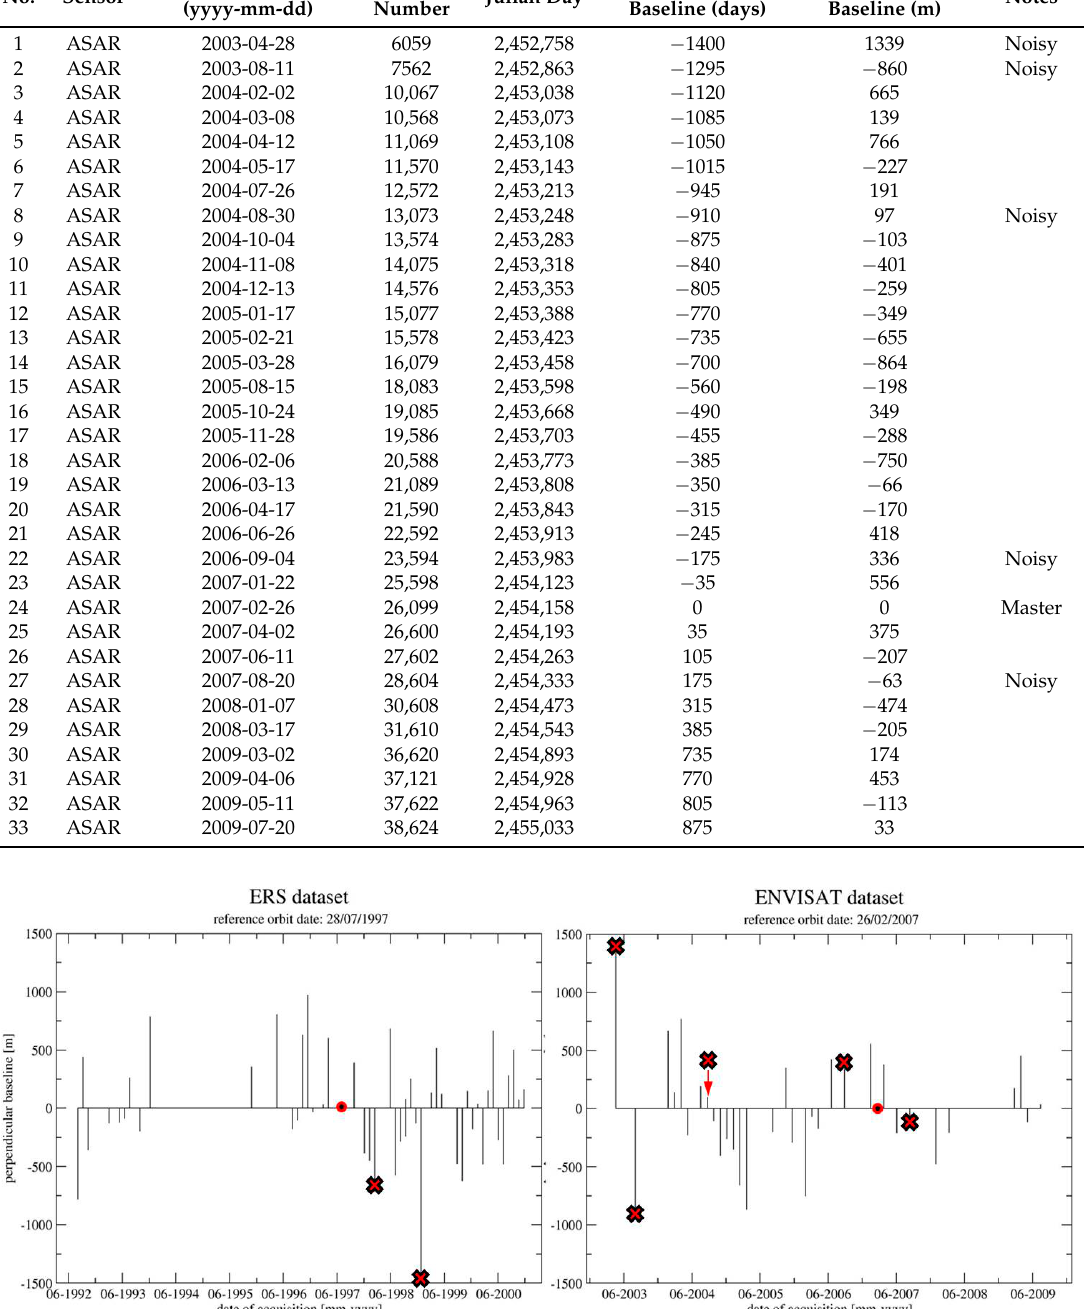
Figure 3. Spatial and temporal baselines of the interferograms. The red spot define the acquisition chosen as reference; red crosses denote noisy interferograms not used in the final processing.